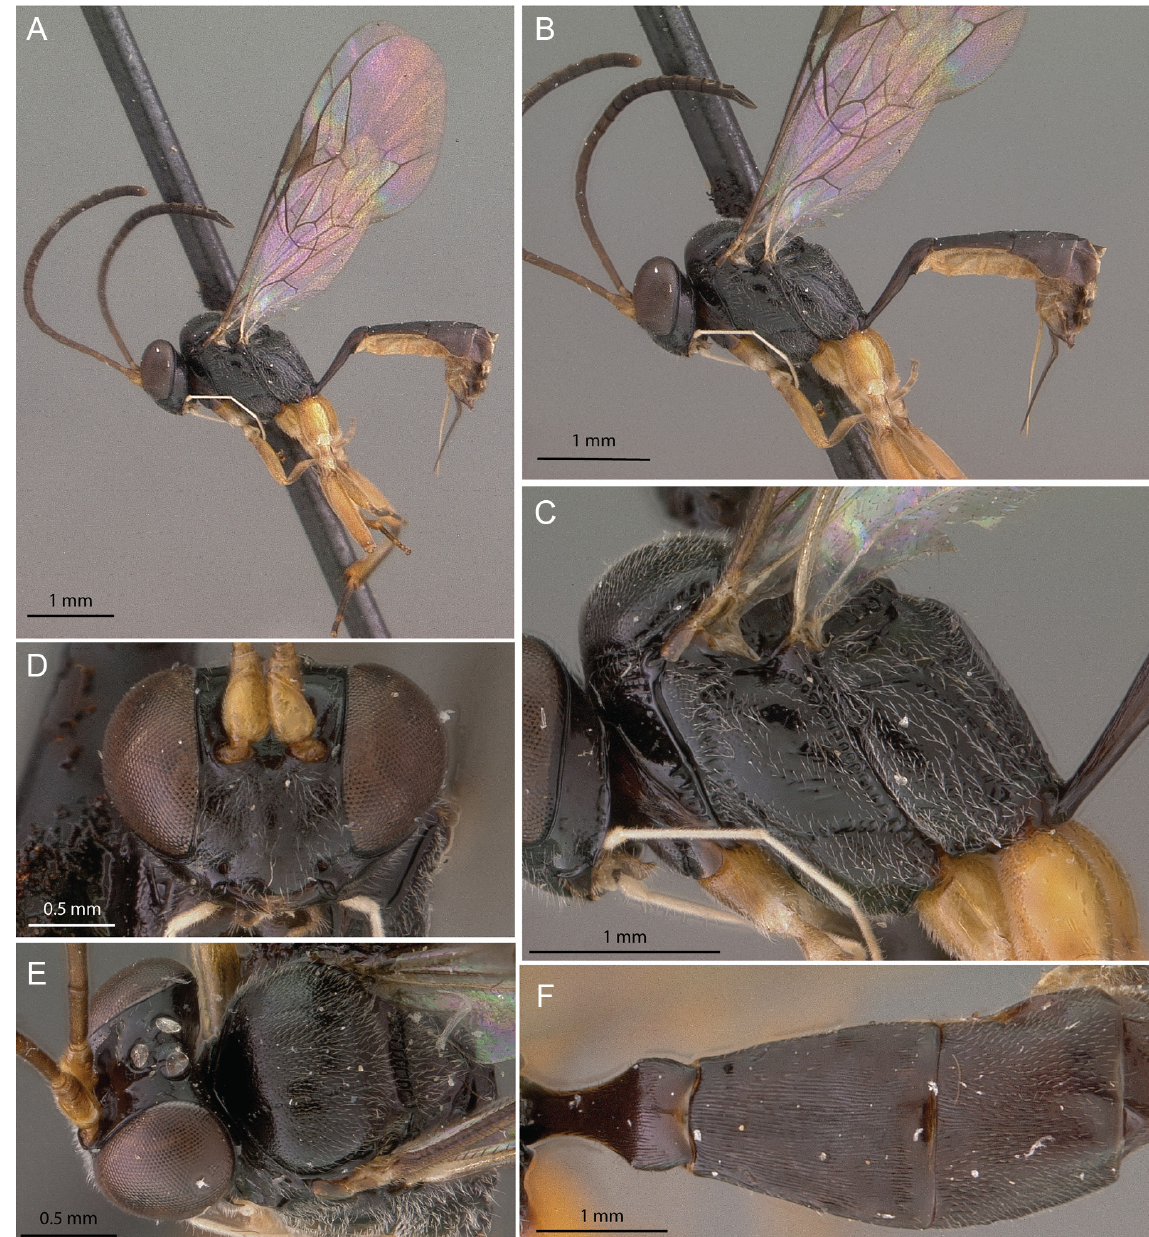
Fig. 23. Palpostilpnus palpator (Aubert, 1961), holotype, ♀ (USUC). A . Lateral habitus. B . Lateral habitus. C . Mesopleuron. D . Head, anterior view. E . Scutum and vertex, dorsal view. F . Part of meta- soma